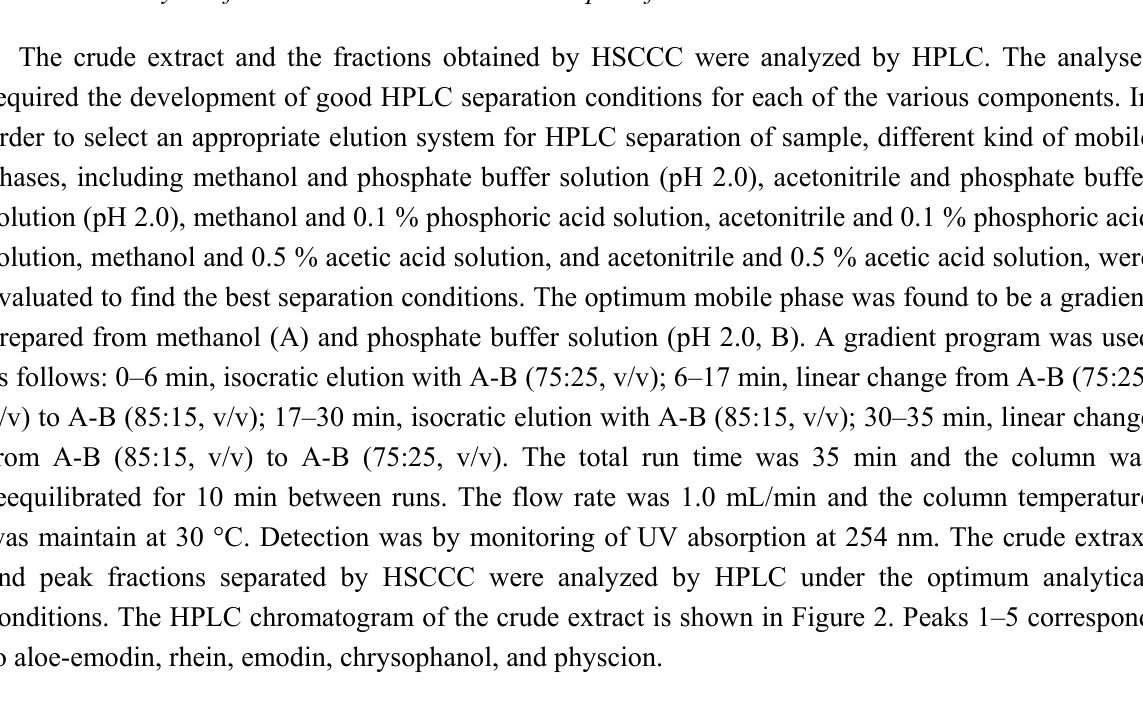
Figure 2. HPLC chromatogram of the crude extract from R. japonicus